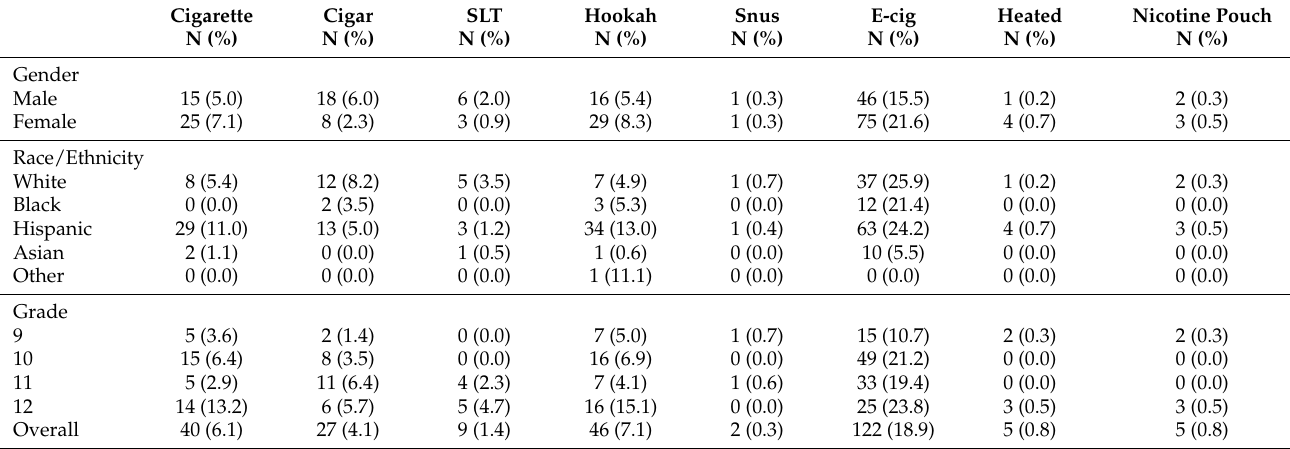
Table 2. Ever use of tobacco products, NJYTS 2021 (n = 702).